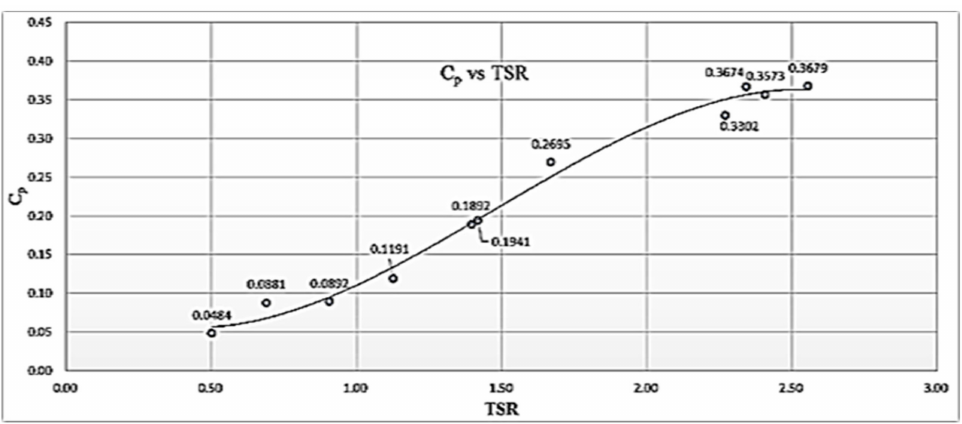
Figure 7. Coe ffi cient of power ( C p ) vs. tip speed ratio (TSR).